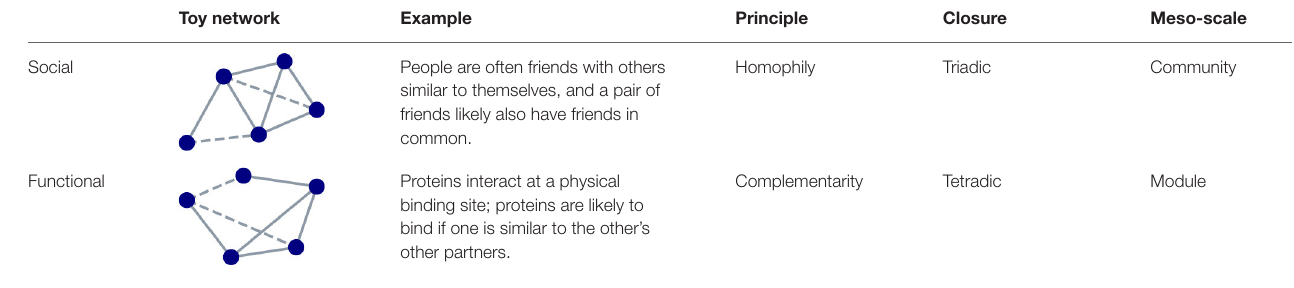
TABLE 1 | Key differences between social and functional networks.